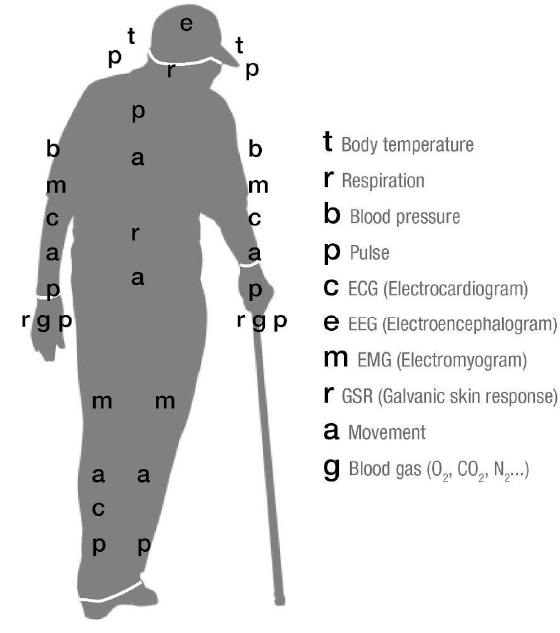
Figure 5. Biomedical signals that can be measured in the human body [44].